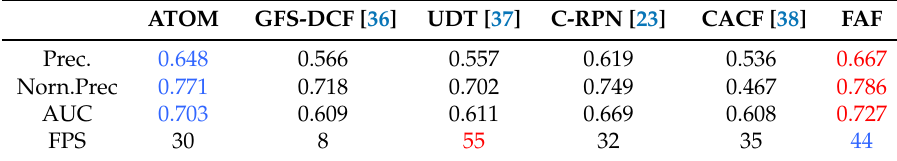
Table 5. Comparison with state-of-the-art trackers on the TrackingNet dataset. The results are presented in terms of precision, normal.precision, and AUC. The best and second results are in red and blue, respectively.